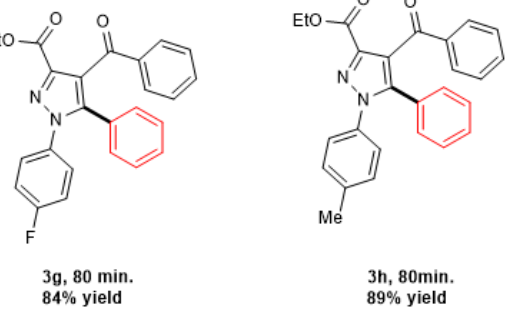
Figure 2. Structure of pyrazole synthesized via C-H arylation utilizing the designed sonophotoreactor.